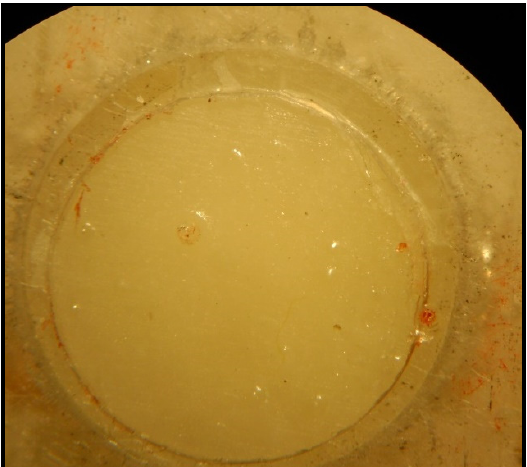
Figure 7. The specimen shows an adhesive type of bond failure.